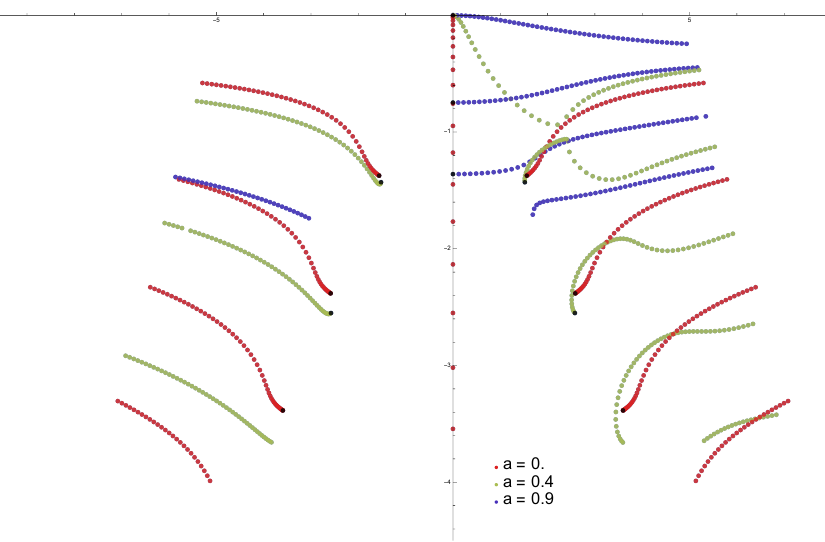
Figure 16 . The vector QNM frequencies shown in (cid:12)gure 5 but displayed in the complex frequency plane. Shown are several values of j where the black point on each curve indicates j =